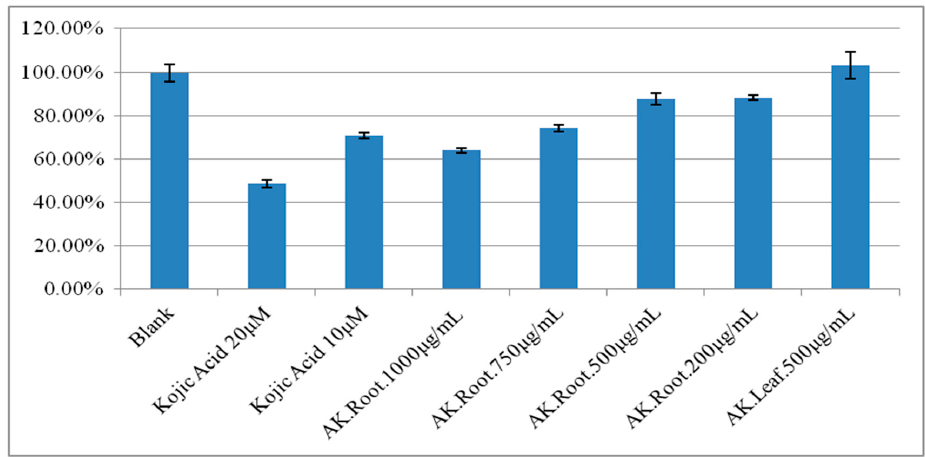
Figure 1. The comparative ratio of tyrosinase activity of the A. keiskei Leaf ( AK . Leaf) at 500 µ g / mL and roots ( AK . Root) at 200, 500, 750 and 1000 µ g / mL concentrations using kojic acid (10 and 20 µ M) as the positive control.